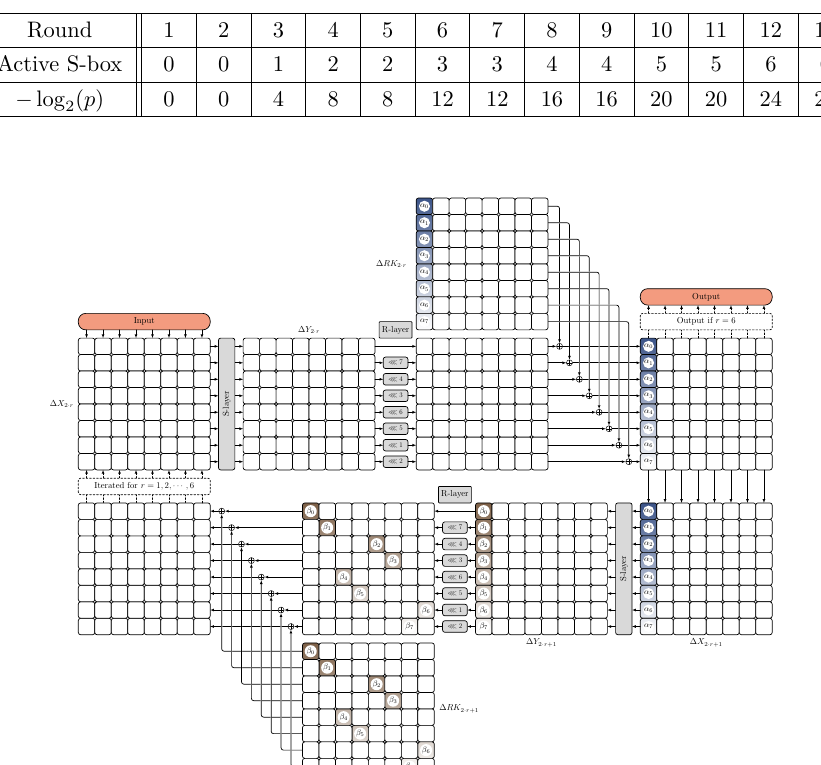
Figure 9: Full-round related-key differential characteristic with probability 2 − 24 for PIPO -128. α 7 ∥ α 6 ∥ α 5 ∥ α 4 ∥ α 3 ∥ α 2 ∥ α 1 ∥ α 0 → β 7 ∥ β 6 ∥ β 5 ∥ β 4 ∥ β 3 ∥ β 2 ∥ β 1 ∥ β 0 represents a possi- ble differential propagation for the S-box with probability 2 − 4